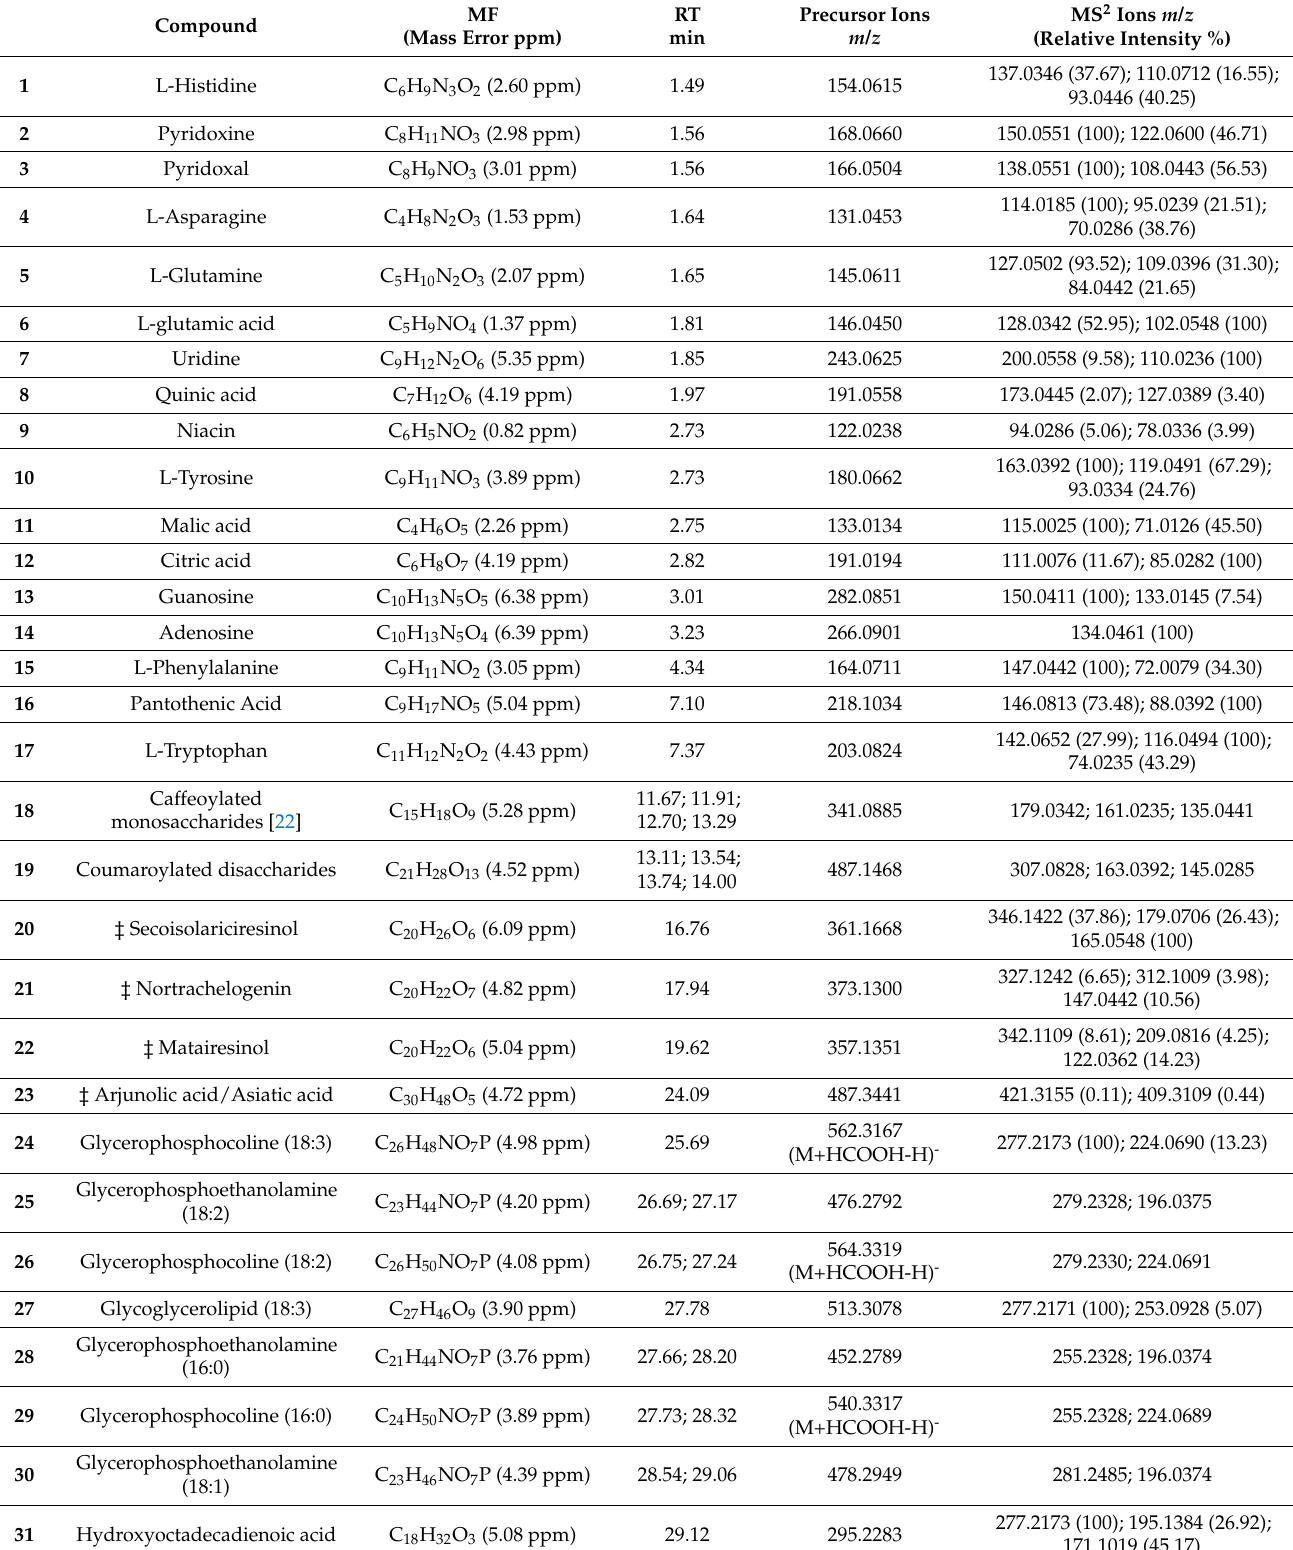
Table 1. Molecular formula (MF), retention time (RT), MS data of compounds identified in JasHEx by GNPS search library and literature